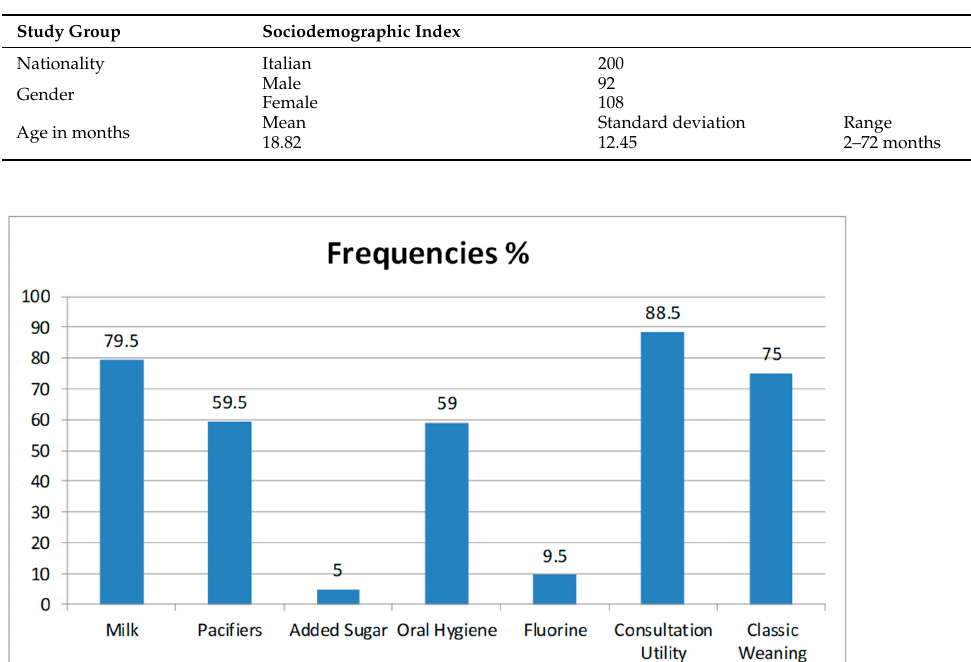
Table A1. Sociodemographic table.